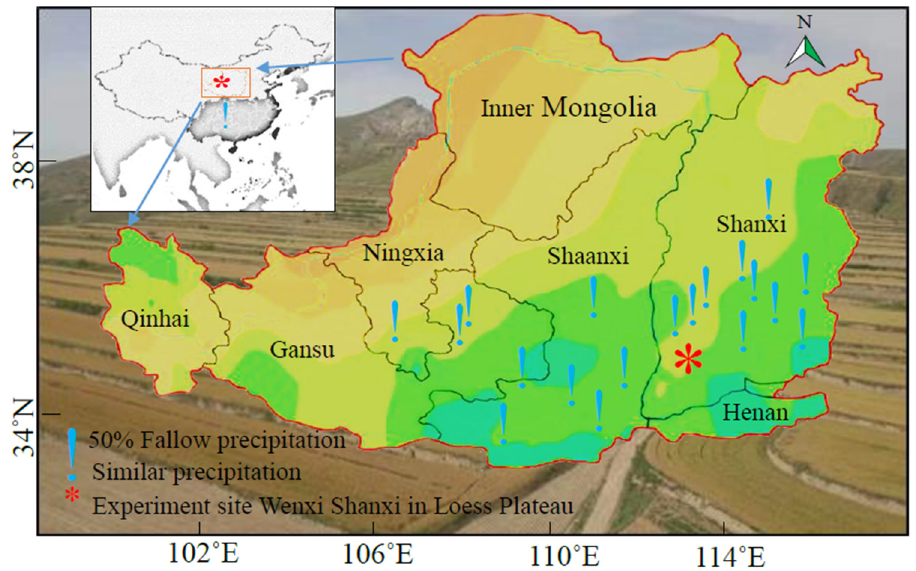
Figure 1. Location of experiment site in the Loess Plateau. The regional distribution of annual pre- cipitation is shown in different colors on the map.